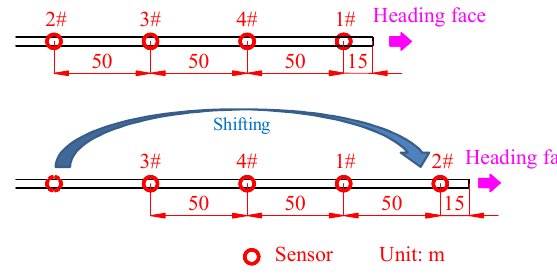
Figure 2. Sensor movement rules.